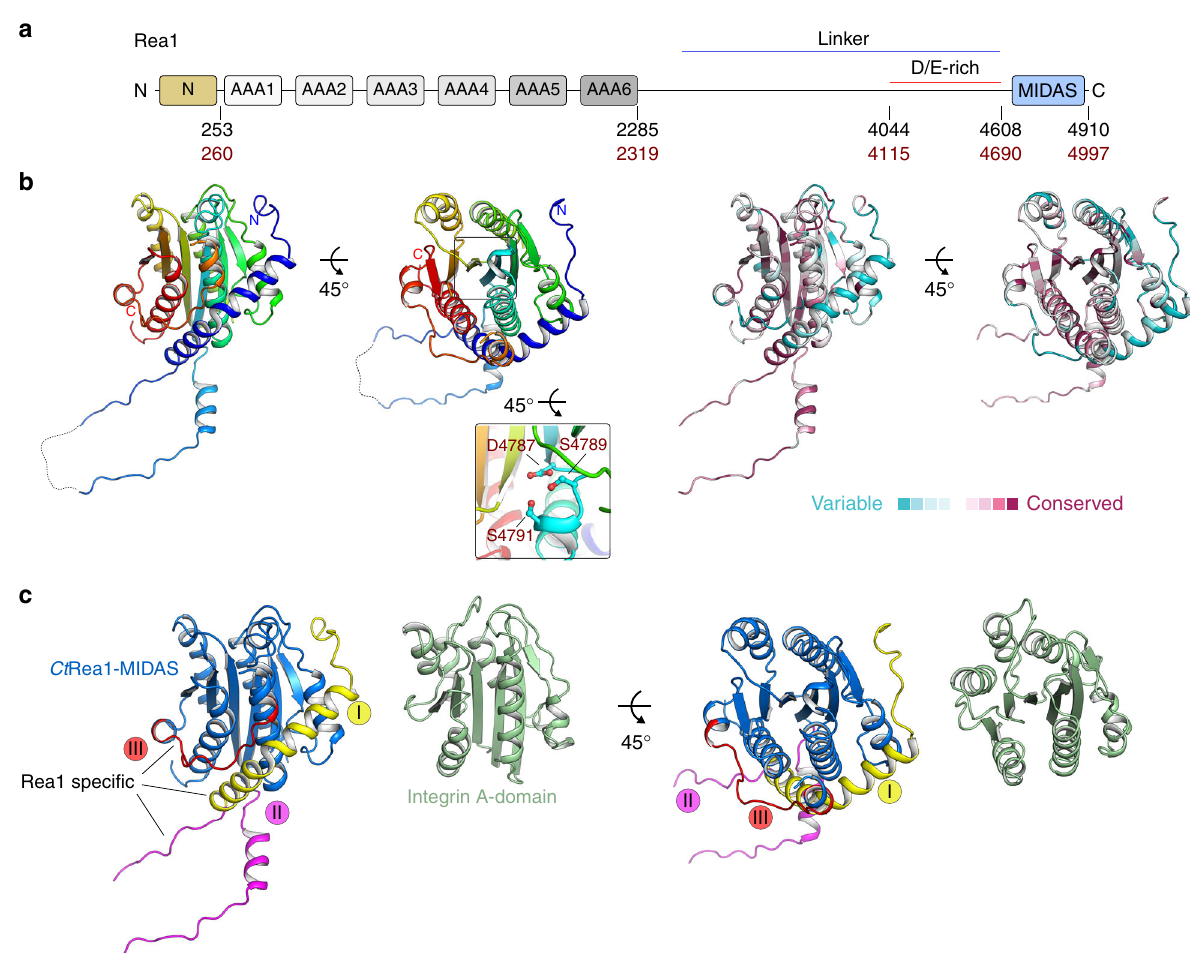
Fig. 1 The crystal structure of the extended Ct Rea1-MIDAS reveals novel Rea1-speci fi c elements. a Domain architecture of Rea1. The domain boundaries are indicated by the residue numbers below for S. cerevisiae (black) and C. thermophilum (red). b Crystal structure of the Rea1-MIDAS domain from C. thermophilum in two orientations. The close-up view highlights the DxSxS motif required for coordination of the divalent metal ion (left-hand structures). A ConSurf analysis of the Ct Rea1-MIDAS domain is shown in the two right-hand structures. Conserved amino acids, maroon; variable amino acids, turquoise. c Structure comparison of the Ct Rea1-MIDAS domain and the integrin A-domain (PDB ID: 1IDO) in two orientations. The integrin A-domain, green; the classical MIDAS fold of Rea1, blue; Rea1-speci fi c elements I – III, yellow, purple, and red,